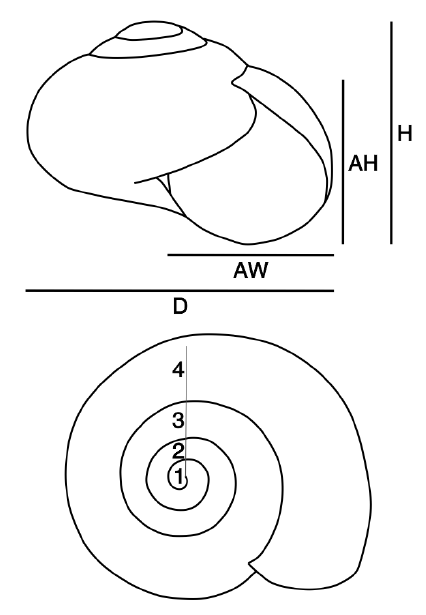
Figure 2 - Shell measurements and whorl count used for Ovachlamys fulgens . Abbreviations: H, height; D, diameter; AH, aperture height; AW, aperture